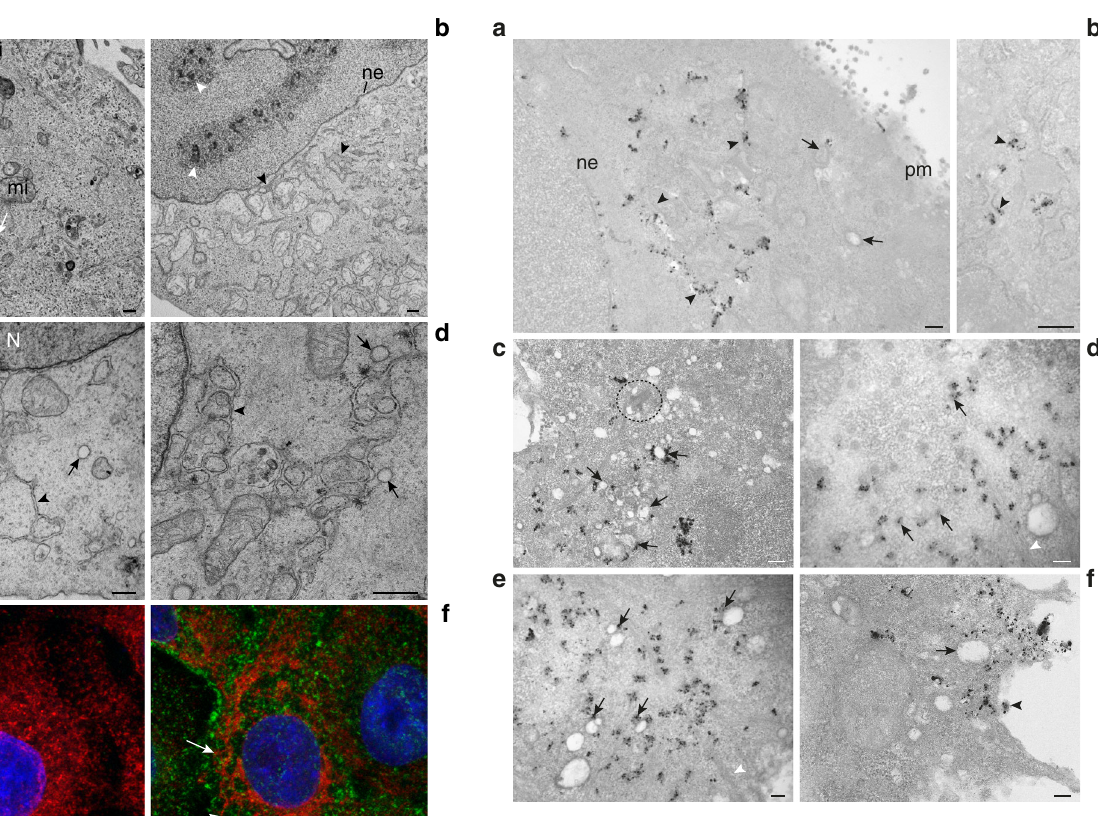
Fig. 4 WSN vRNPs are detected in the ER and ICVs by METTEM. A549 cells infected with the recombinant virus WSN-PB2-MT were treated with gold salts at 8 hpi, fi xed and incubated with silver to increase the diameter of gold nanoclusters built by the MT tag. Cells were post- fi xed with osmium tetroxide, sectioned, stained and studied by TEM. a Cell showing labeled vRNPs in nuclear envelope (ne), in ER (arrowheads), ICVs (arrows) and close to plasma membrane (pm). b Higher magni fi cation from a different cell showing labeled vRNPs in ER membranes (arrowhead). c Cell section through the MTOC showing label in ICVs (arrows) around the centriole (dashed circle). d Cell sectioned through the nuclear envelope showing vRNPs in nuclear pores (arrows) and close to fi laments (arrowhead). e Signal associated with vRNPs in ICVs (arrows) and close to fi laments (arrowheads). f Signal associated with vRNPs in a region close to plasma membrane. An ICV (arrow) and budding viruses (arrowhead) are